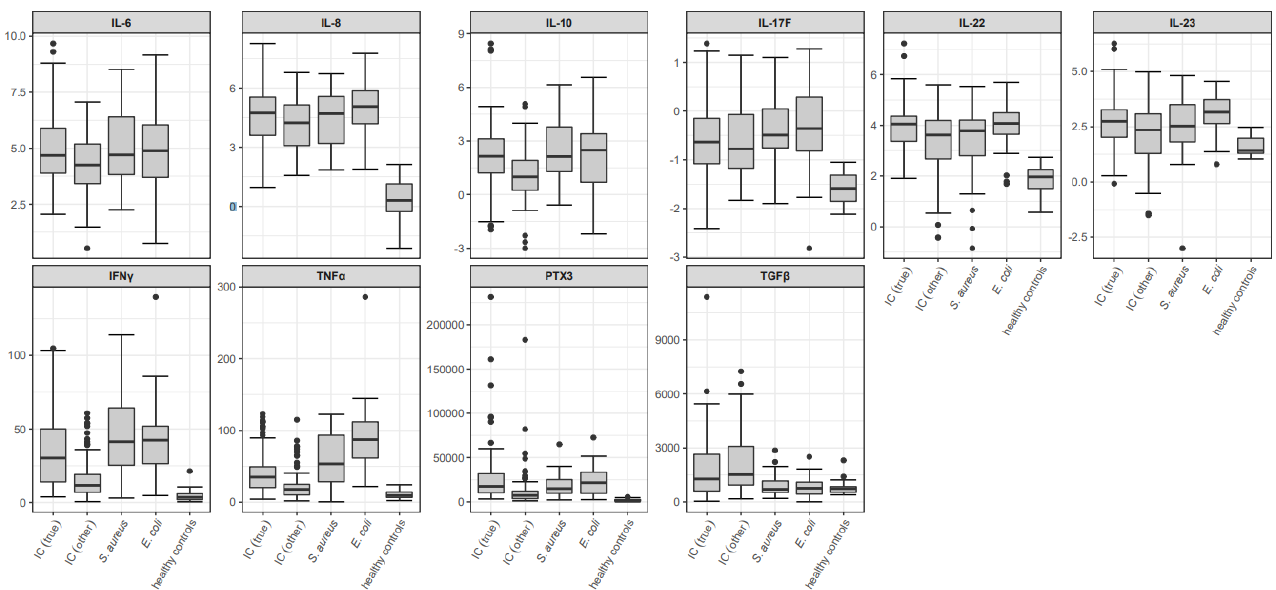
Figure 2. Boxplots of designated cytokine values (IL-6, IL-8, IL-10, IL-17F, IL-22, IL-23, IFN-γ, TNF-α, PTX3, TGF-β) for the total study population at time interval (−1; 2) relative to index sampling. Values of interleukin parameters are depicted on the logarithmic scale; other values are given in pg/mL. In the boxplots, median values are depicted as bold line and the box spans from first to third quartile; whiskers extend to a maximum of 1.5 times the interquartile range (IQR, third minus first quartile) out from the respective box end; all remaining values are indicated as dots. IL = interleukin. IFN-γ = interferon-γ. PTX3 = Pentraxin-related protein 3. TNF-α = tumor necrosis factor-α. TGF-β = transforming growth factor-β. IC = invasive candidiasis. IC (true) = patients with true candidemia. IC (other) = patients with candidemia of unclear significance (positive blood cultures from central veins only), proven IC other than candidemia, and patients with probable and possible IC. S. aureus = patients with S. aureus bacteremia. E. coli = patients with E. coli bacteremia. Table 4. Comparison of cytokine values other than interleukin 17A (IL-6, IL-8, IL-10, IL-17F, IL-22, IL-23, IFN-γ, TNF-α, PTX3, TGF-β) between the different study groups at time interval (−1; 2) ( p -values).